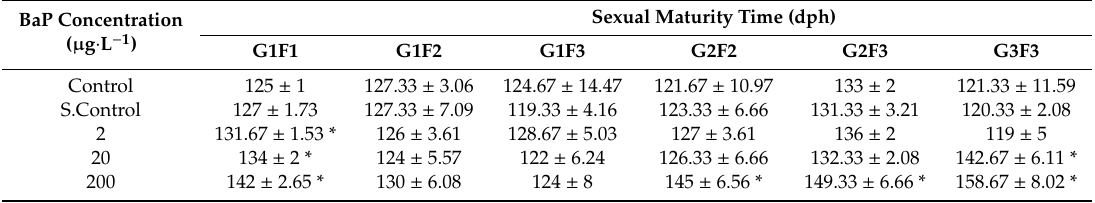
Table 3. Sexual maturity time of marine medaka in di ff erent groups exposed to